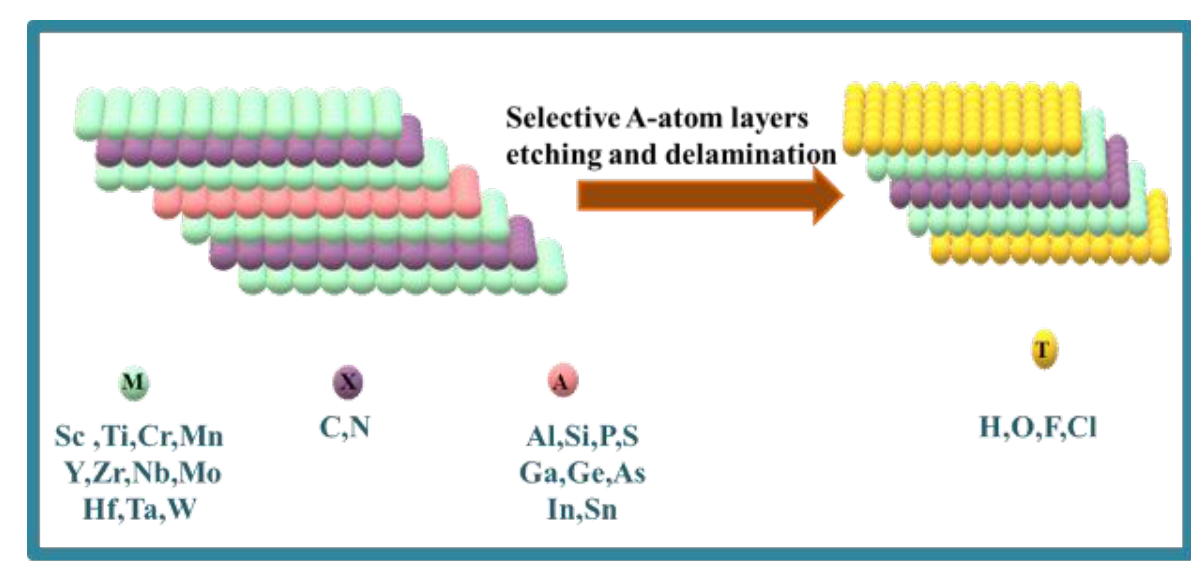
Figure 1. Structural representation of MXene.